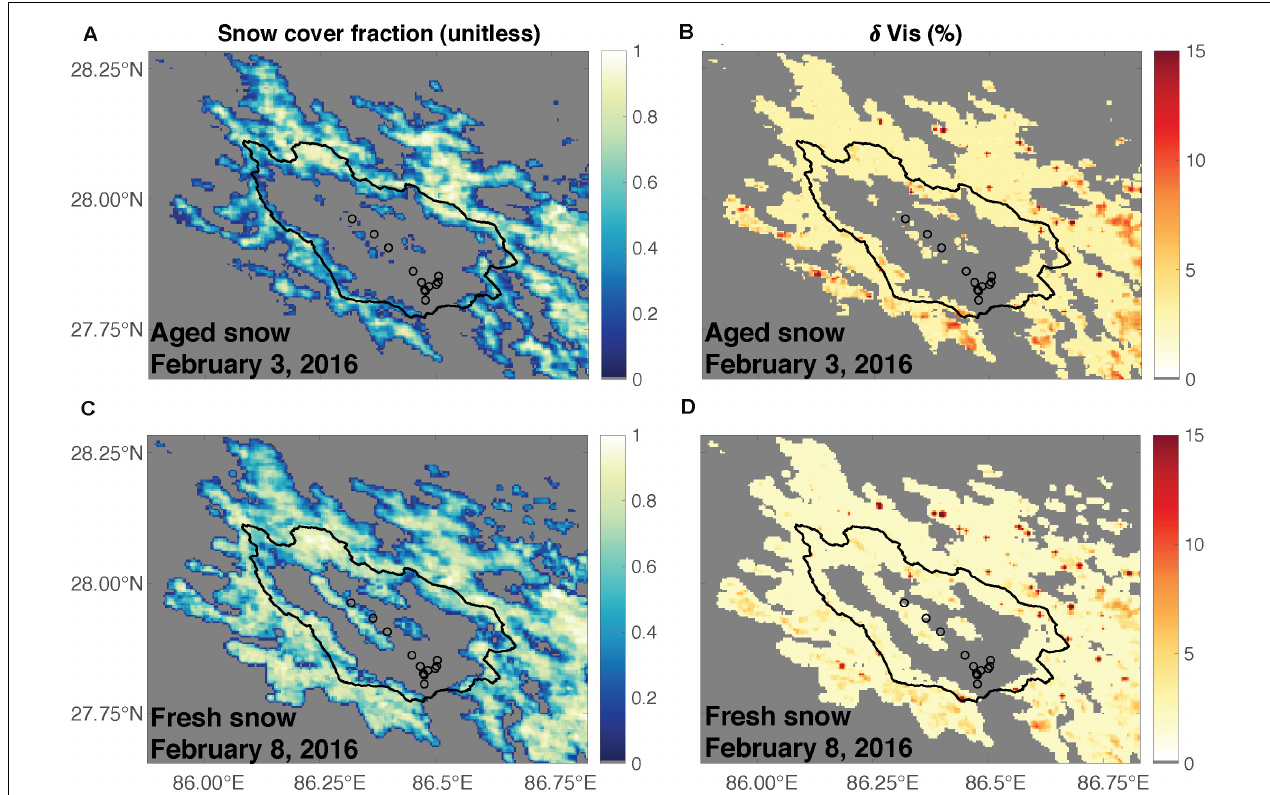
FIGURE 3 | Snow covered area from spatially and temporally complete MODIS Snow Covered Area and Grain size algorithm (MODSCAG) (A,C) , (cid:49) vis from spatially and temporally complete MODIS Dust and Radiative Forcing algorithm (MODDRFS) (B,D) for February 3 (aged snow) and February 8 (fresh snow). Latitude and longitude are shown on the x and y axis, respectively. The dots represent sampling locations and the solid line represents the watershed for the headwaters of the Dudh Koshi